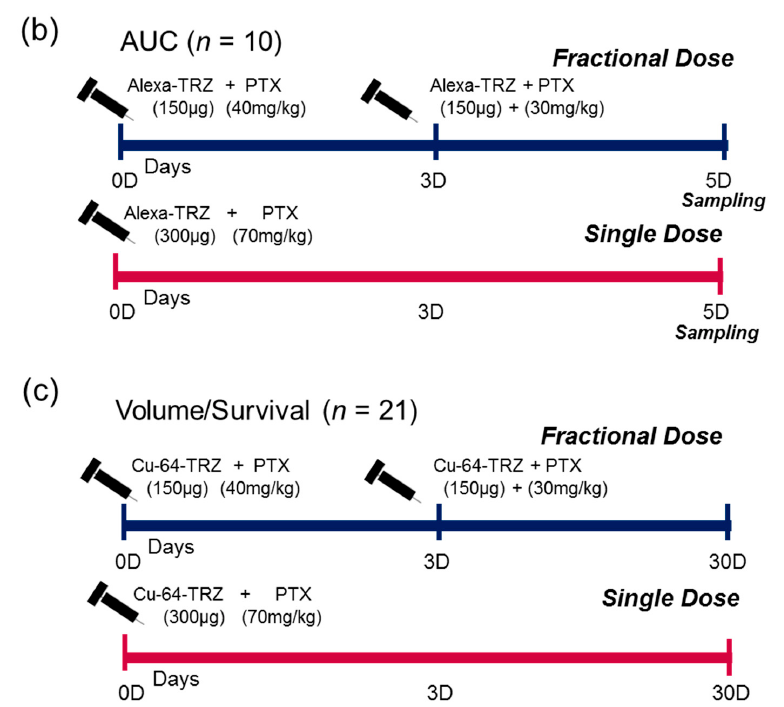
Figure 1. Schematic design of combination therapy by evaluating drug delivery and efficacy. ( a ) Single dose (SD) and fractionated dose (FD) of combination therapy were injected into NCI-N87 xenograft-bearing mice, and penetration of mAb was evaluated from the vessel, near the edge, and total accumulation across the tumor. ( b ) Experimental schedule for Alexa-647-congugated TRZ and Cu-64-labeled-TRZ. ( c ) SD and FD dosage regimens. Cu-64-TRZ, Cu-64-Trastuzumab; Alexa-647-TRZ, Alexa-647-Trastuzumab; PTX, paclitaxel. TRX, trastuzumab.